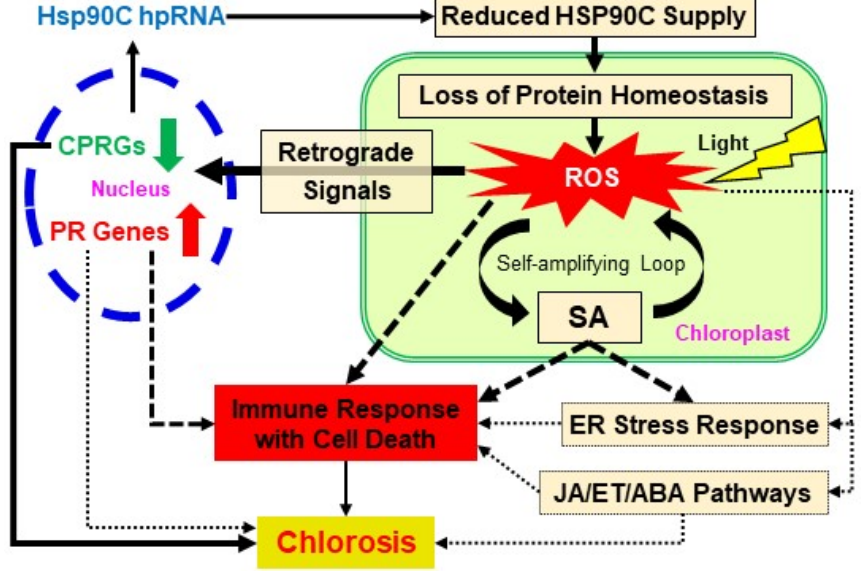
Figure 7. A schematic model for the molecular mechanism of chlorosis. Inducible silencing of the HSP90C gene causes a reduction of HSP90C levels in the chloroplast, which causes the loss of protein homeostasis in the chloroplast. The disruption of protein homeostasis leads chloroplasts to produce ROS in a light-dependent manner. The effects of ROS and SA are enhanced by a self-amplifying loop. ROS serves as the chloroplast retrograde signal and activates other retrograde signaling pathways, leading to the upregulation of pathogenesis-related (PR) genes and the downregulation of chloroplast- and photosynthesis-related genes (CPRGs). Reduced supply of HSP90C in the chloroplast induces the activation of the ER stress response and the upregulation of JA/ET/ABA pathway genes, likely through SA, ROS, or other signaling pathways. ROS, SA, the activation of PR genes, and other stress responses including JA/ET/ABA pathways could stimulate the cell death pathway. The downregulation of CPRGs may be the primary cause of chlorosis, and ROS-mediated triggering of HR-like cell death in the chlorotic tissues could have a role in the development of chlorosis. Solid line arrows indicate the steps with experimental support, whereas broken line arrows are hypothetical.